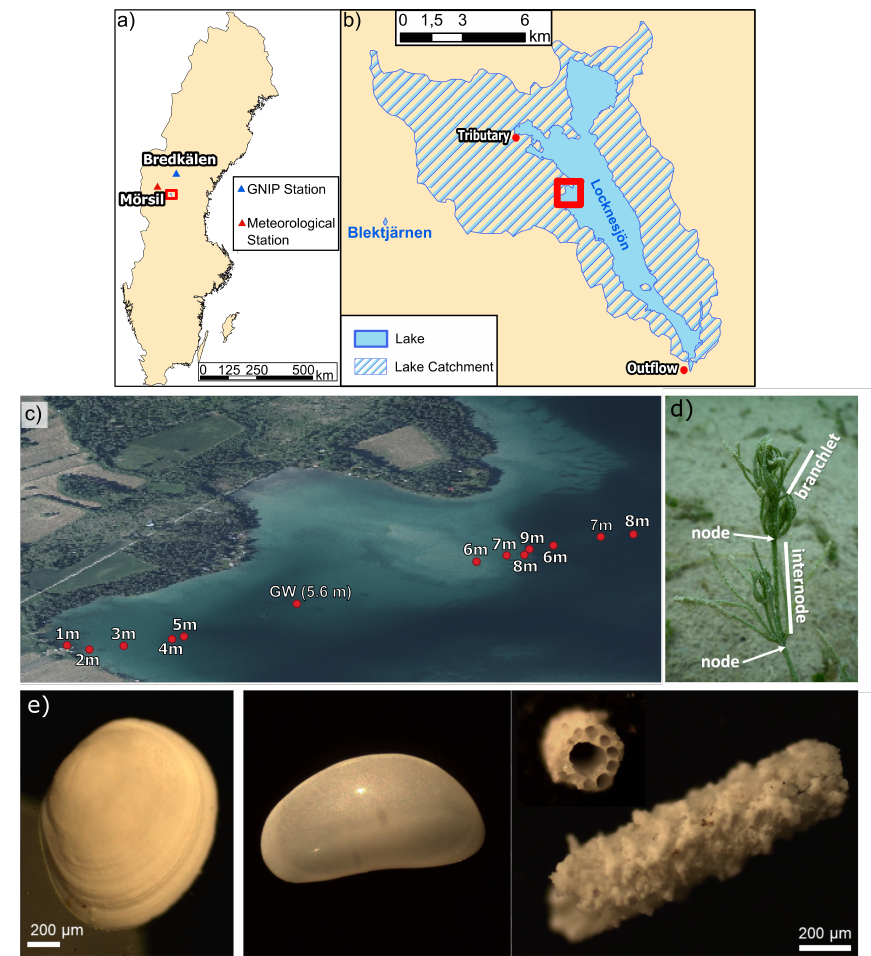
Figure 2. (a) Map of Sweden showing the location of the study area (red rectangle), of the GNIP station Bredkälen and of the meteorological station Mörsil. (b) Lake Locknesjön with its catchment (hatched) and Lake Blektjärnen. (c) Locations of the sampling sites on a transect from the shore towards the center of the lake. The area shown in (b) is marked by the red rectangle in (a) and the area shown in (c) is marked in (b) (country outline from USGS, lake and catchment outline from SMHI, 2020a; orthophoto © Lantmäteriet 2020). (d) Photograph of a Chara hispida in Lake Locknesjön. An internode (between two nodes) and a branchlet are indicated on the image. The part of the Chara hispida visible on the photograph measures about 2cm in height. (e) Images of different lacustrine biogenic carbonates analyzed in this study: (left) Pisidium valve, (middle) adult Candona candida valve, (right) Chara hispida